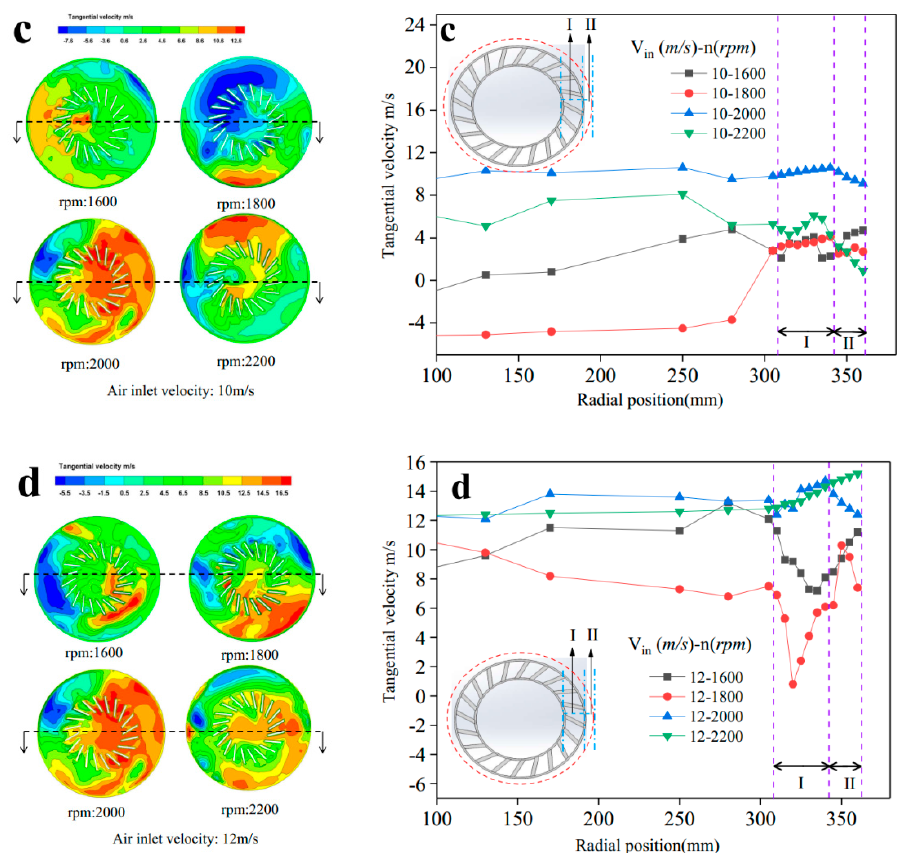
Figure 3. Contours of the tangential velocity distribution and air tangential velocity contrast under di ff erent radial distances from the axis at di ff erent process parameters (305–345 mm is the area between the rotor blades, 345–365 mm is the annular zone). ( a ) Air inlet velocity 6 m / s and 4 di ff erent rotor cgae speed. ( b ) Air inlet velocity 8 m / s and 4 di ff erent rotor cgae speed. ( c ) Air inlet velocity 10 m / s and 4 di ff erent rotor cgae speed. ( d ) Air inlet velocity 12 m / s and 4 di ff erent rotor cgae speed